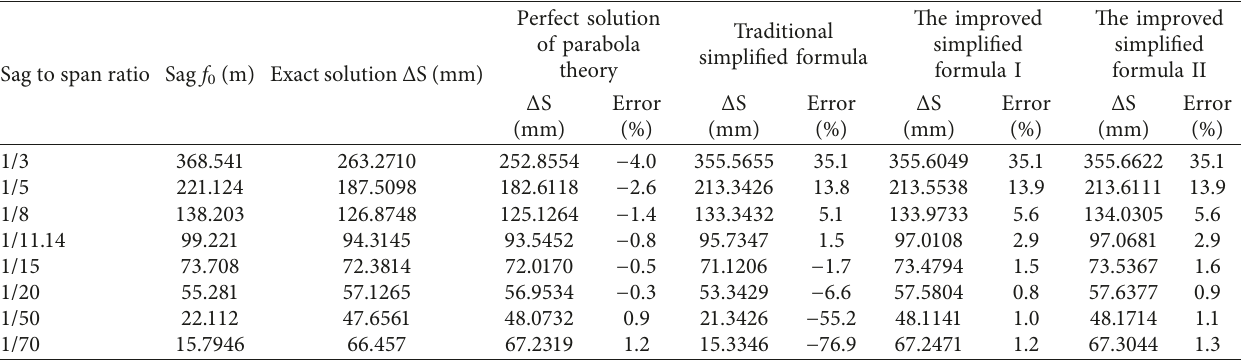
Table 3: Comparison of length adjustment results for datum strand in side span with different sag-span ratios. Sag to